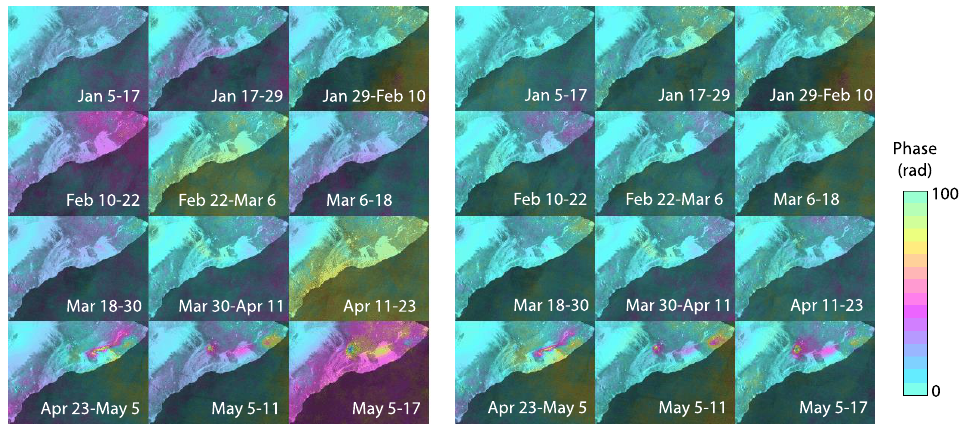
Figure 2. Sequence of 12 example interferograms (January–May 2018) from Hawaii stack, before ( a , at left) and after ( b , at right) regression correction. The corrected images display much less variation with time than the uncorrected images, hence, the derived time series will be more accurate as the average phase of each scene is equalized. The color scale repeats every 100 radians so that both large and small deformation are visible. Table 1. Average RMS GPS/InSAR error, cm. For each site, rms difference is computed (as in Figure 4) both (with) using the atmosphere correction described here, and (without) using the standard single reference point algorithm. Results are shown for SBAS solutions with maximum temporal baselines of 12, 30, and 100 days. The 100-day solutions reduce the atmosphere more through averaging but lose some signal from undersampling the phase gradient (see text). RMS Errors